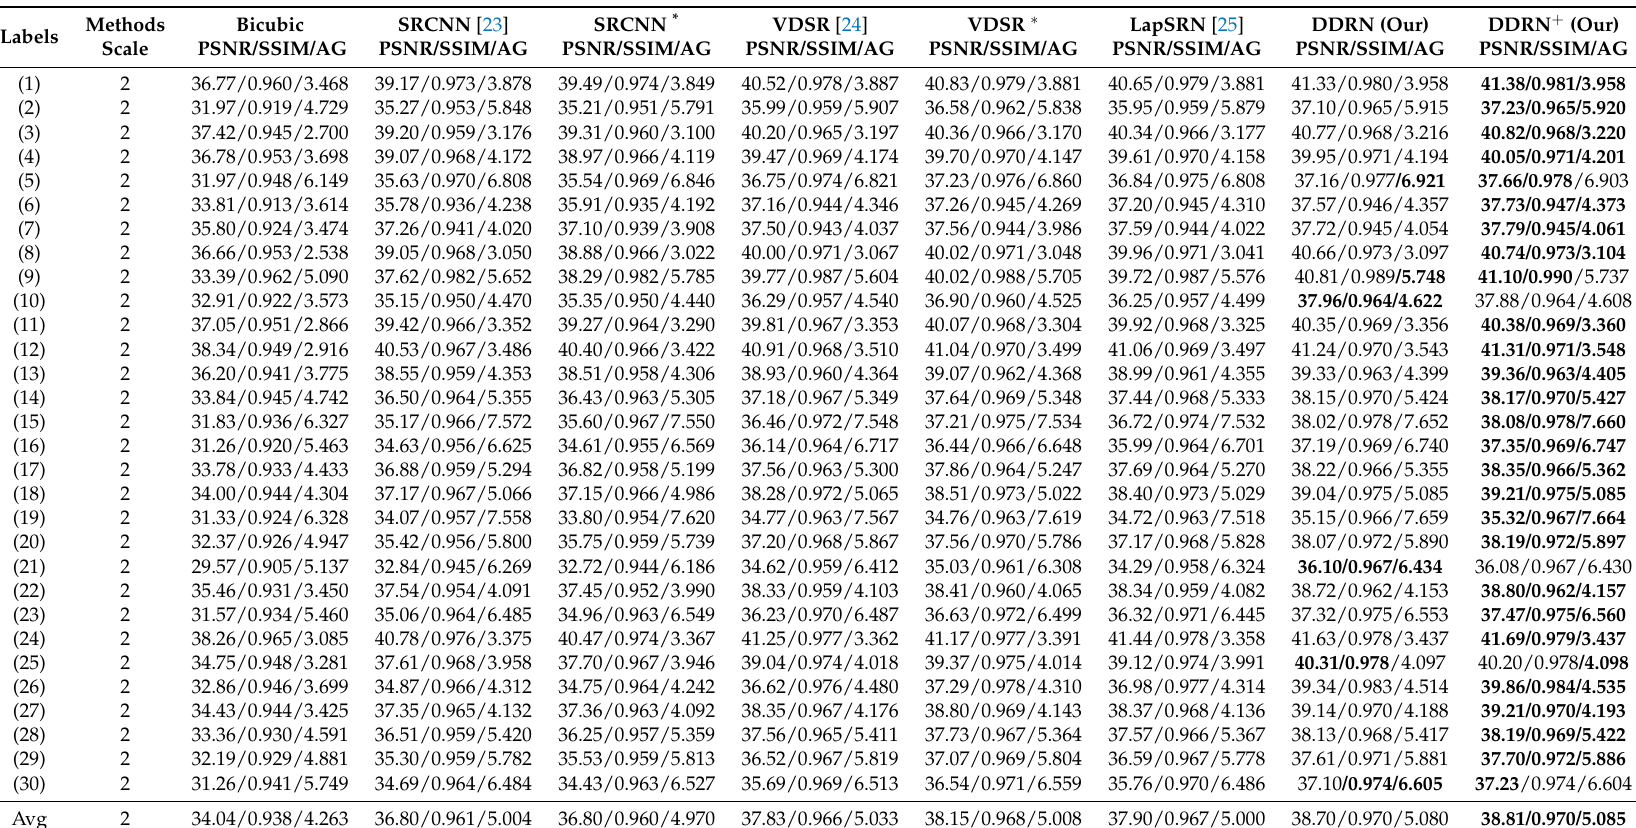
Table 1. Quantitative evaluation of the proposed DDRN approach and its improved version DDRN + against some state-of-the-art SISR algorithms on Kaggle Open Source Dataset with 30 different scenarios for the scale factor of × 2. Bold indicates the best performance. Particularly, ∗ refers to the modules retrained by us with Kaggle Open Source Dataset